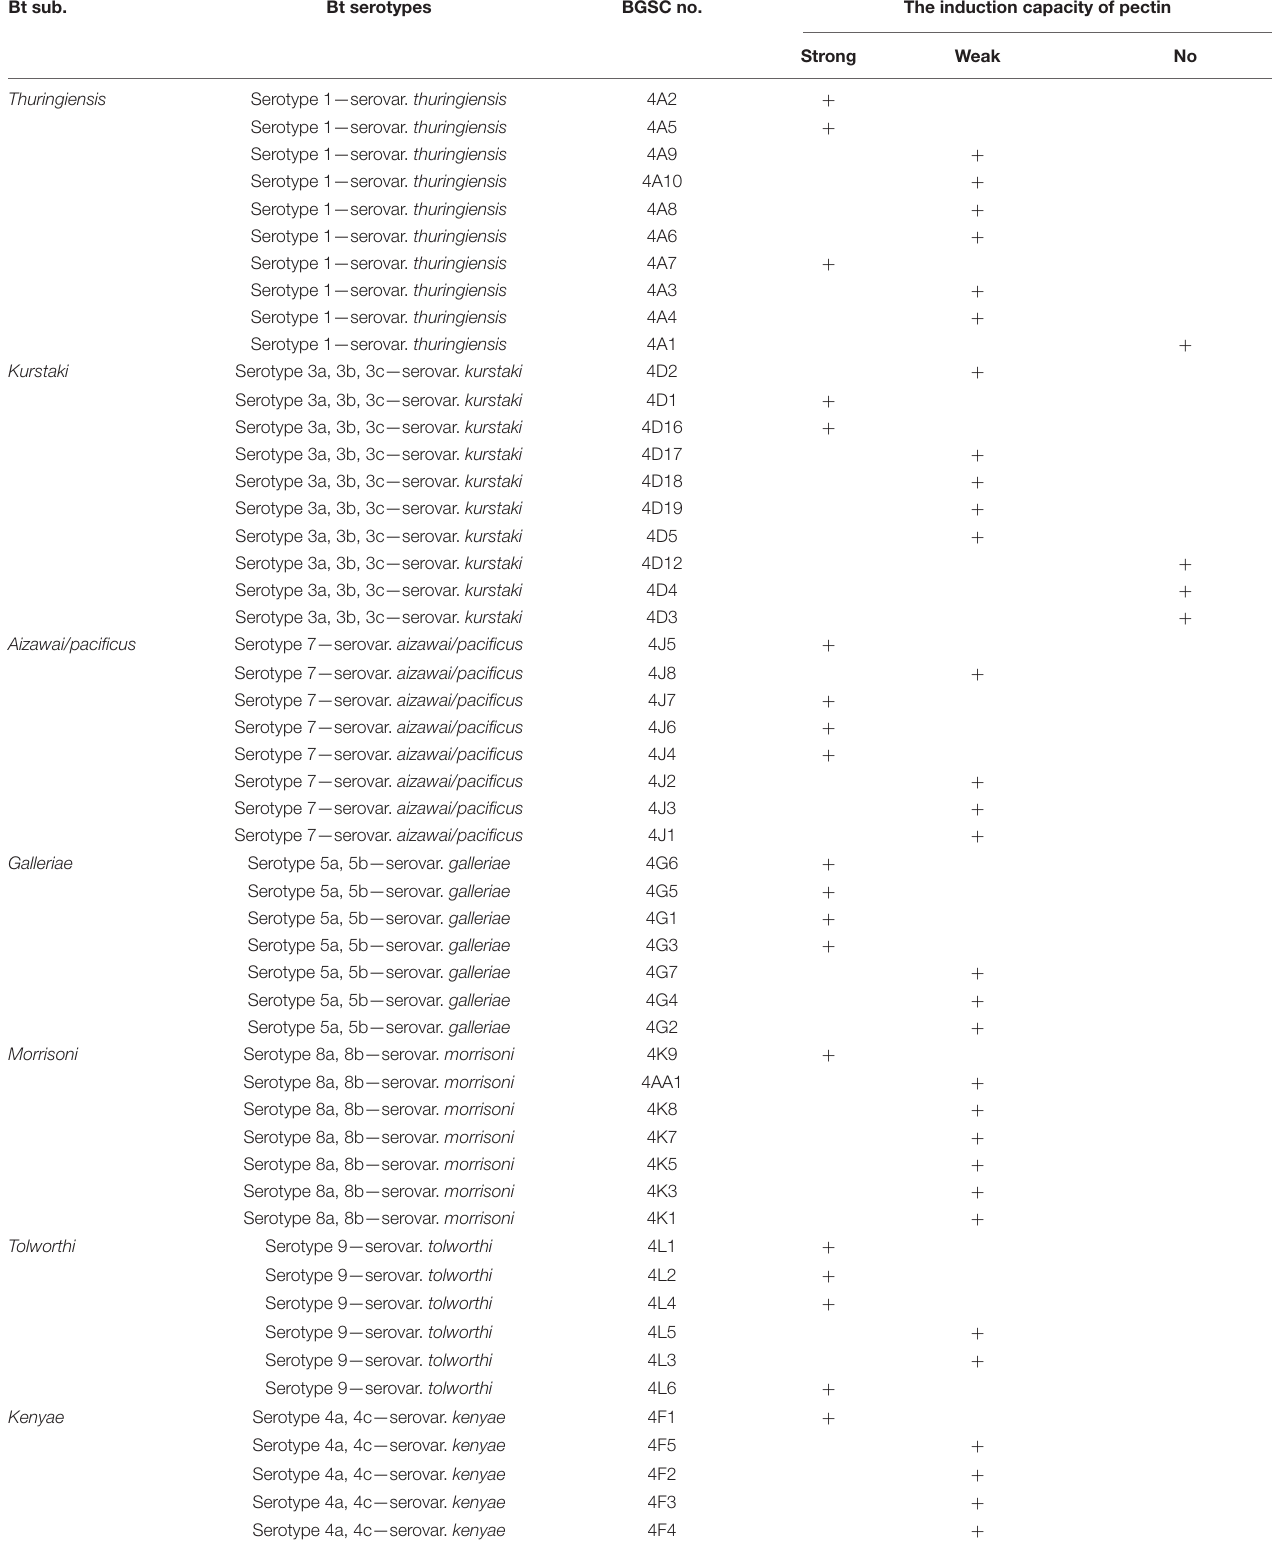
TABLE 1 | Comparison of induction ability of pectin on the biofilms formed by different Bt serotypes. Bt sub. Bt serotypes BGSC no. The induction capacity of pectin